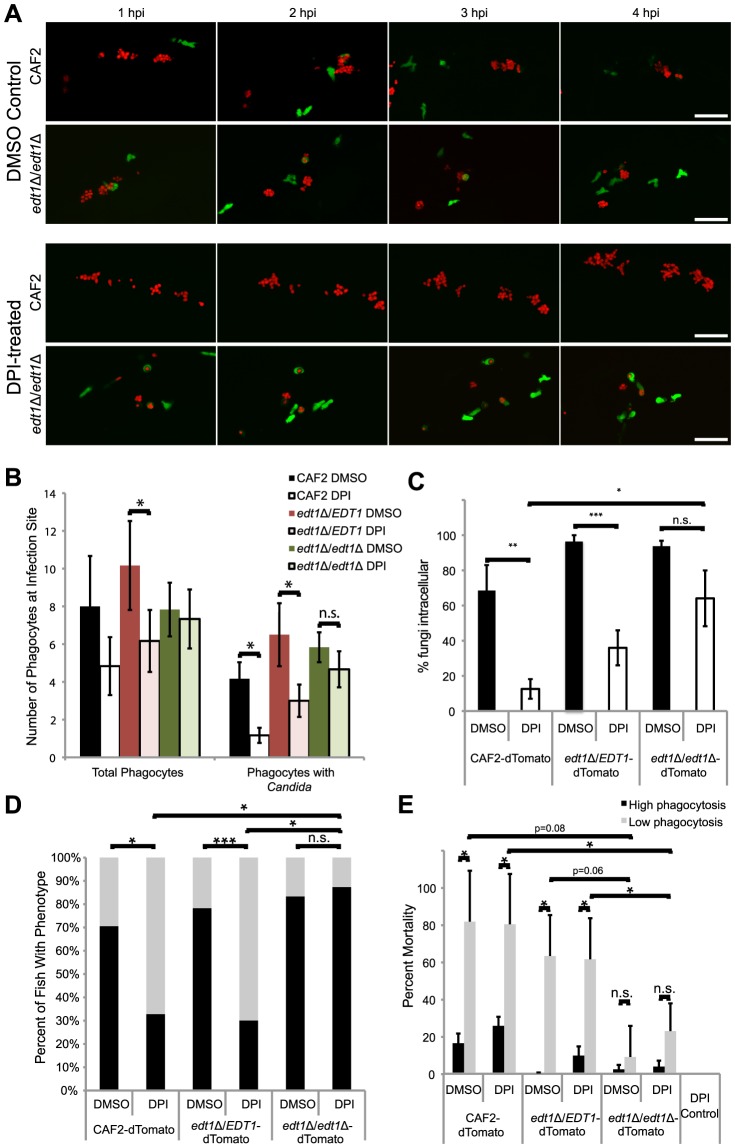
The EDT1-dependent morphogenetic switching pathway plays roles in NADPH oxidase-independent phagocyte migration and virulence.(A–E) prim25 stage Tg(mpx:GFP)i114 larvae were injected with CAF2-dTomato, edt1Δ/Δ-dTomato, or edt1Δ/EDT1-dTomato C. albicans. Fish were incubated with DMSO or DPI from two hours pre-infection until 4 hpi, and imaged by confocal microscopy. At 4 hpi phagocyte migration and phagocytosis were quantified and fish were sorted into high- and low-responder categories, and at 24 hpi fish were scored for survival. (A) Images are representative of three independent experiments; n = 6 for each fungal genotype and treatment group. Time-lapse images from edt1Δ/EDT1 infections are indistinguishable from wildtype infections but are not shown due to space considerations. Scale bar = 50 µm. (B) Quantitation of total phagocyte response and number of phagocytes with internalized fungi shows the average and standard error from fish pooled from three independent experiments; n = 6 for each fungal genotype and treatment group. (C) Phagocytosis efficiency was measured in fish pooled from three independent experiments; n = 6 for each fungal genotype and treatment group. (D) Survival percentage of low- and high-responders was measured for each of three independent experiments, and the means are shown; n = 70–74 for each group. (E) Low mortality of low-responders infected with yeast-locked edt1Δ/Δ mutant. Means and standard errors of mortality percentages of low- and high-responders at 24 hpi are shown. (B–E) Data represent three independent experiments. Means and standard errors are shown. Differences between groups were assessed by two-tailed Student's T-test (B, C, and E) or Fisher's exact test (D). *p<0.05, **p<0.01, ***p<0.001, n.s. no significant difference.